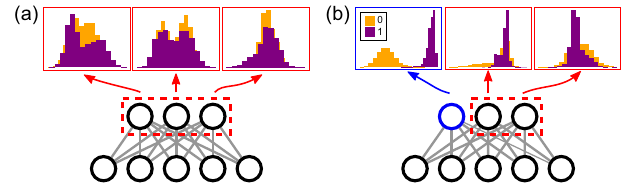
FIG. 3. Model schema. (a) Constraints imposed on all hidden units promote overlapping hidden input distributions of the two classes. (b) Constraints imposed on a subset of hidden units (red) promote class separation on the remaining hidden units